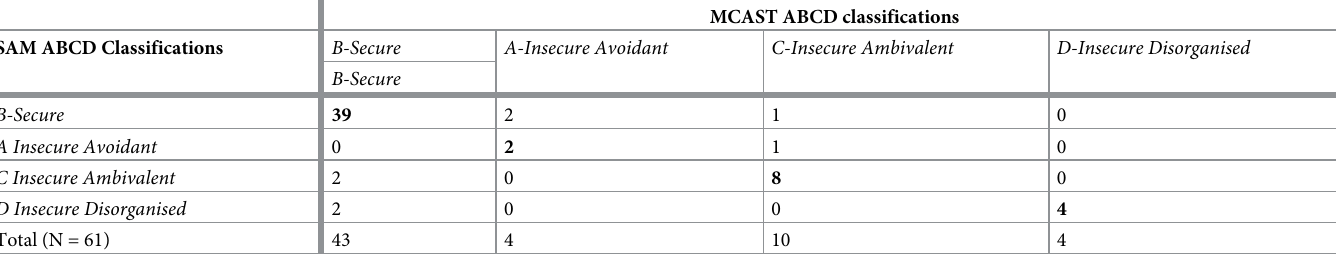
Table 2. Inter-measure agreement across MCAST and SAM (N =